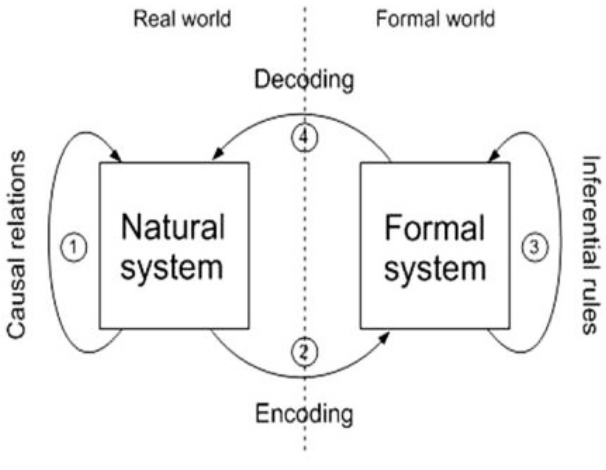
Fig. 1. The modeling relationship (Rosen 1985, 1991, Casti